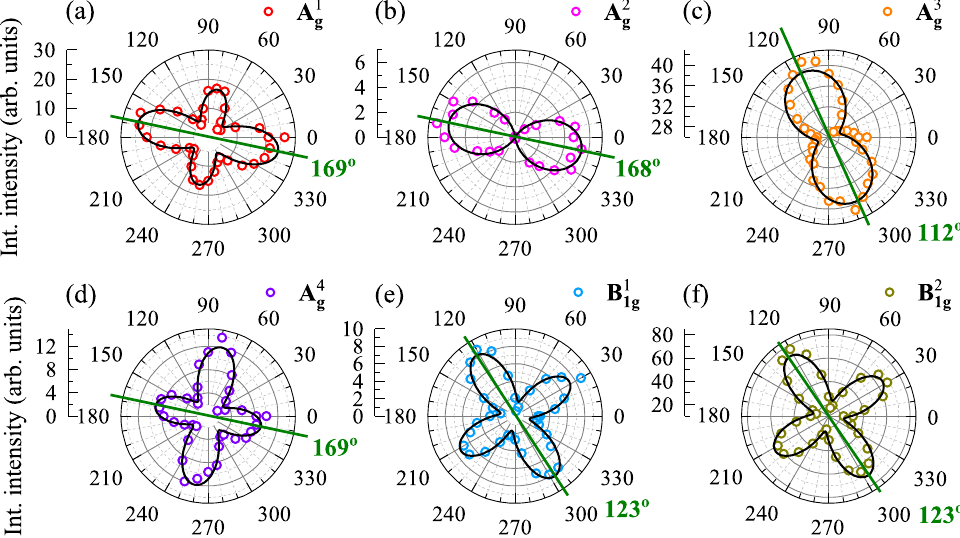
Figure 5. Polar plots of the integrated intensities of the phonon modes: ( a ) A 1 g , ( b ) A 2 g , ( c ) A 3 g , ( d ) A 4 g , ( e ) B 1 g , and ( f ) B 2 g , measured on GeS at T = 300 K under 1.96 eV excitation. The green lines on polar plots are along polarization axes of